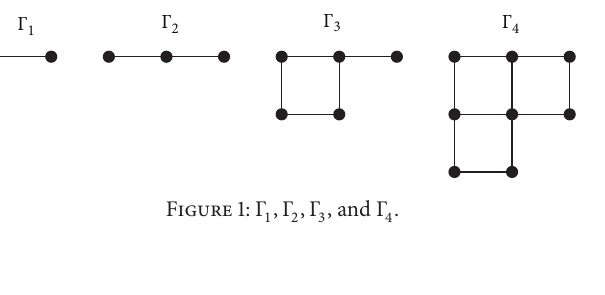
Figure 1: Γ 1 , Γ 2 ,Γ 3 , and Γ 4 .